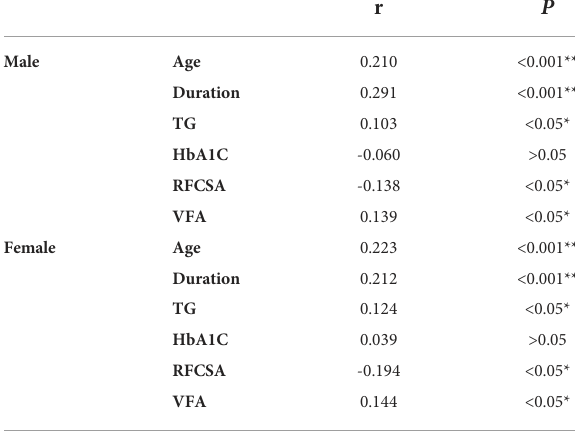
TABLE 3 Spearman ’ s correlation analysis of different prognosis risk of DKD with Clinical characteristics in T2DM patients strati fi ed by